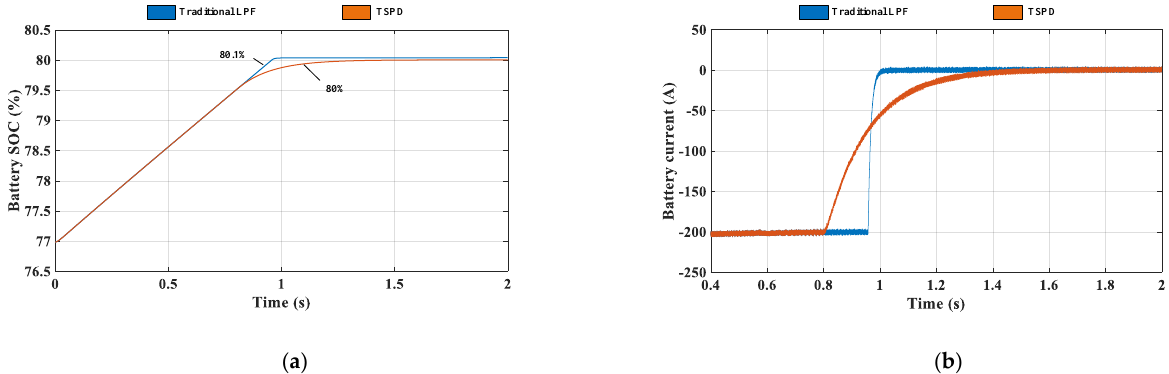
Figure 12. ( a ) Battery SOC under different control strategies; ( b ) Battery current waveform under different control strategies.